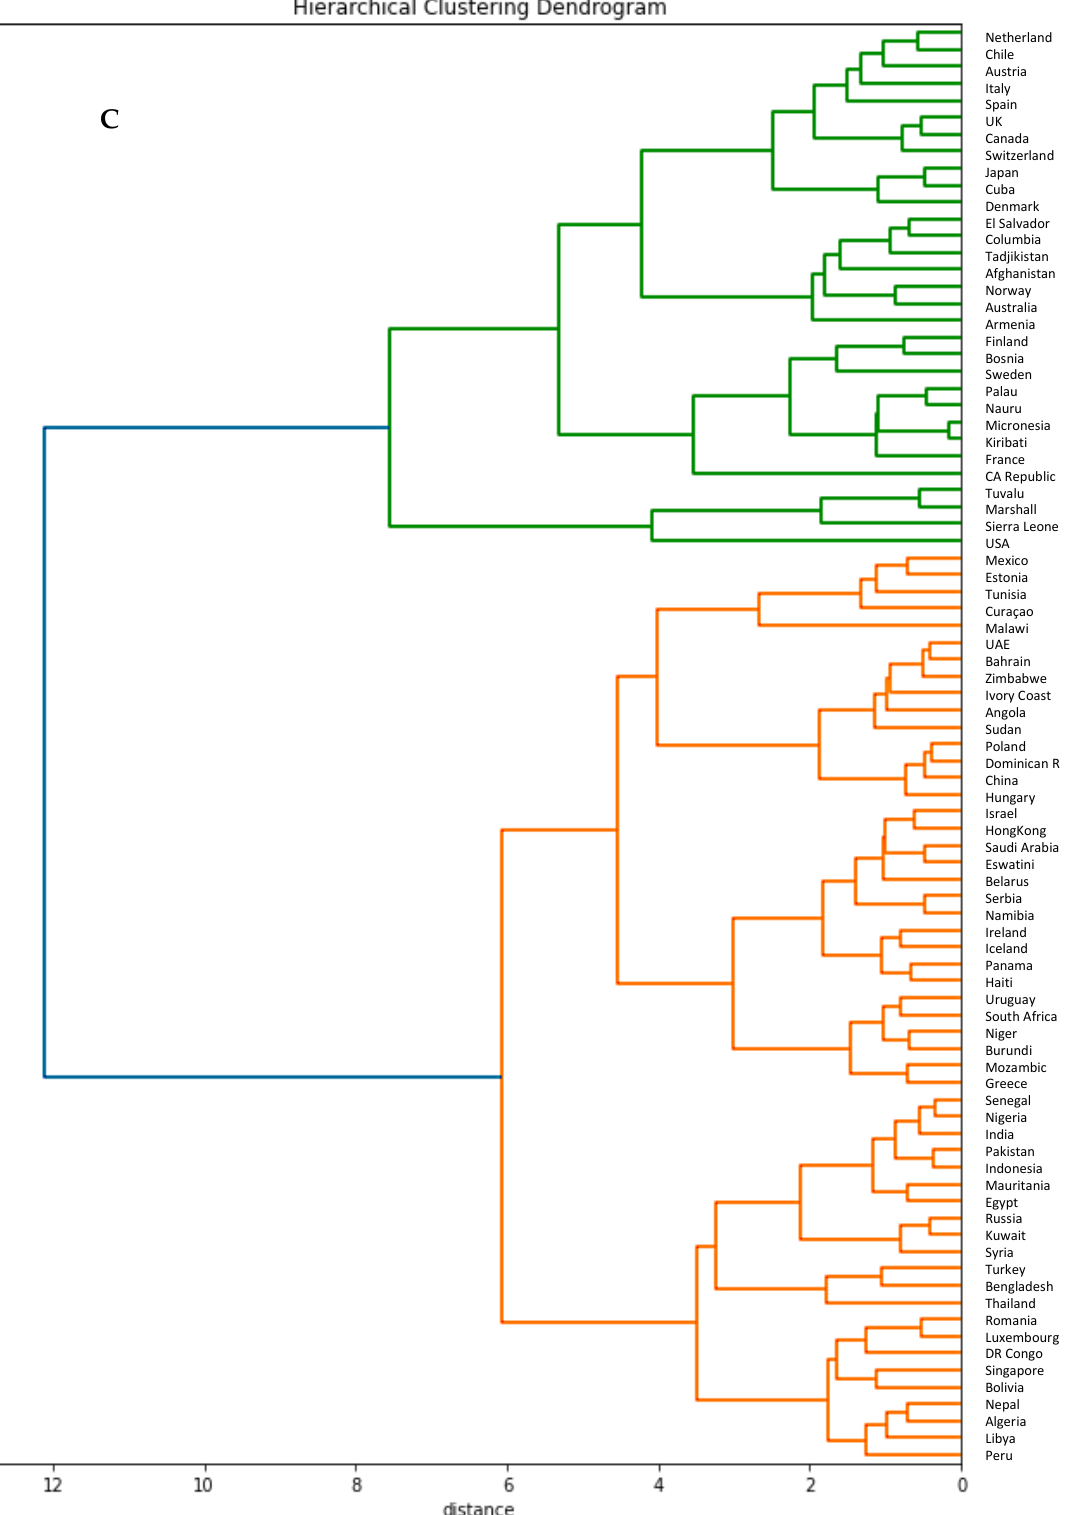
Figure 10. ( a ) Boxplots of the clusters corresponding to the hierarchical clustering. Visualizations of ( b ) more “developing” (in red with some notable exceptions such as the Czech Republic and Germany) and ( c ) more “developed” (in green and partially in orange) countries parts of the hierarchy